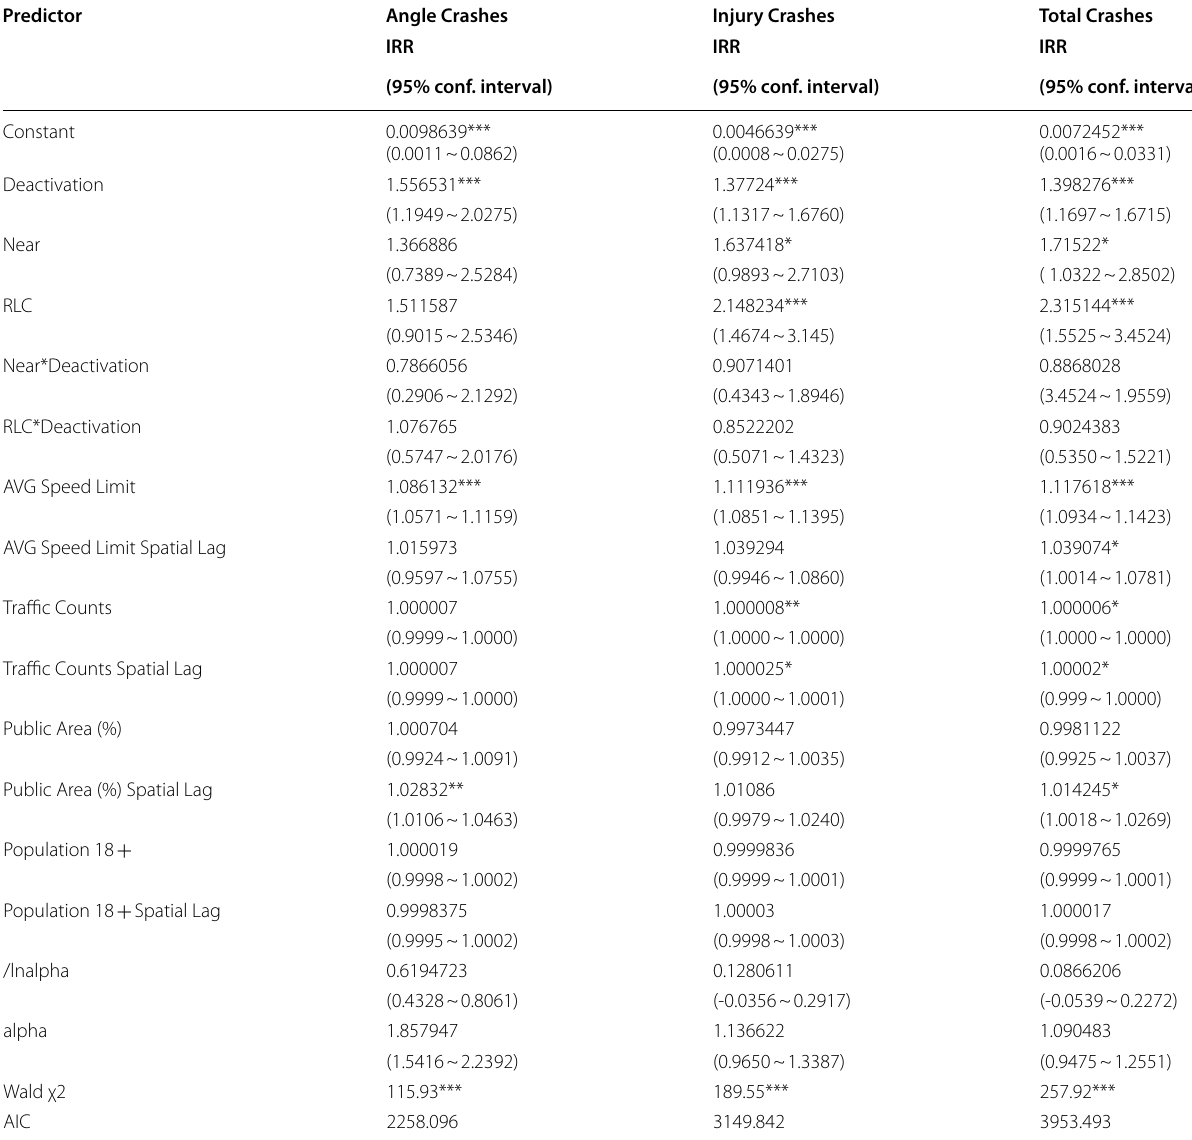
Table 7 Model results by types of crashes